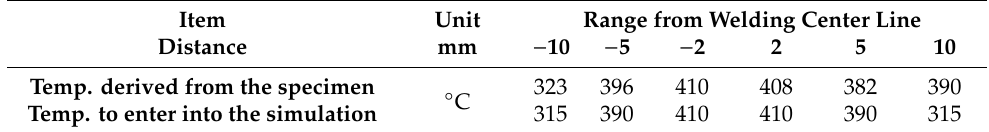
Figure 15. Pre-process of heat transfer analysis: ( a ) FSW sequence; ( b ) method to enter temperature in the welding center; ( c ) moving method of heat source. Table 9. Temperature to enter into full structure analysis.